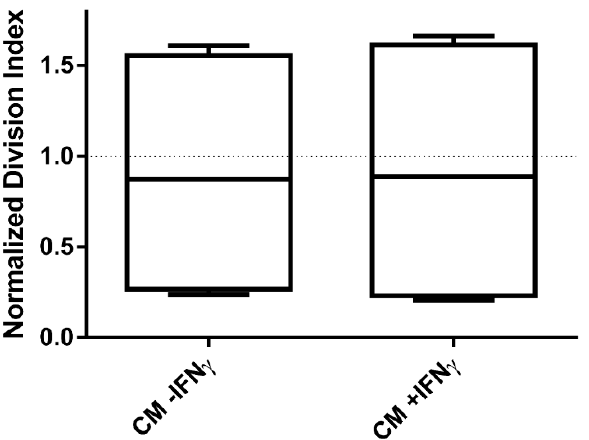
Figure 4. CM transferred from a previous coculture was ineffective in exerting PBMC